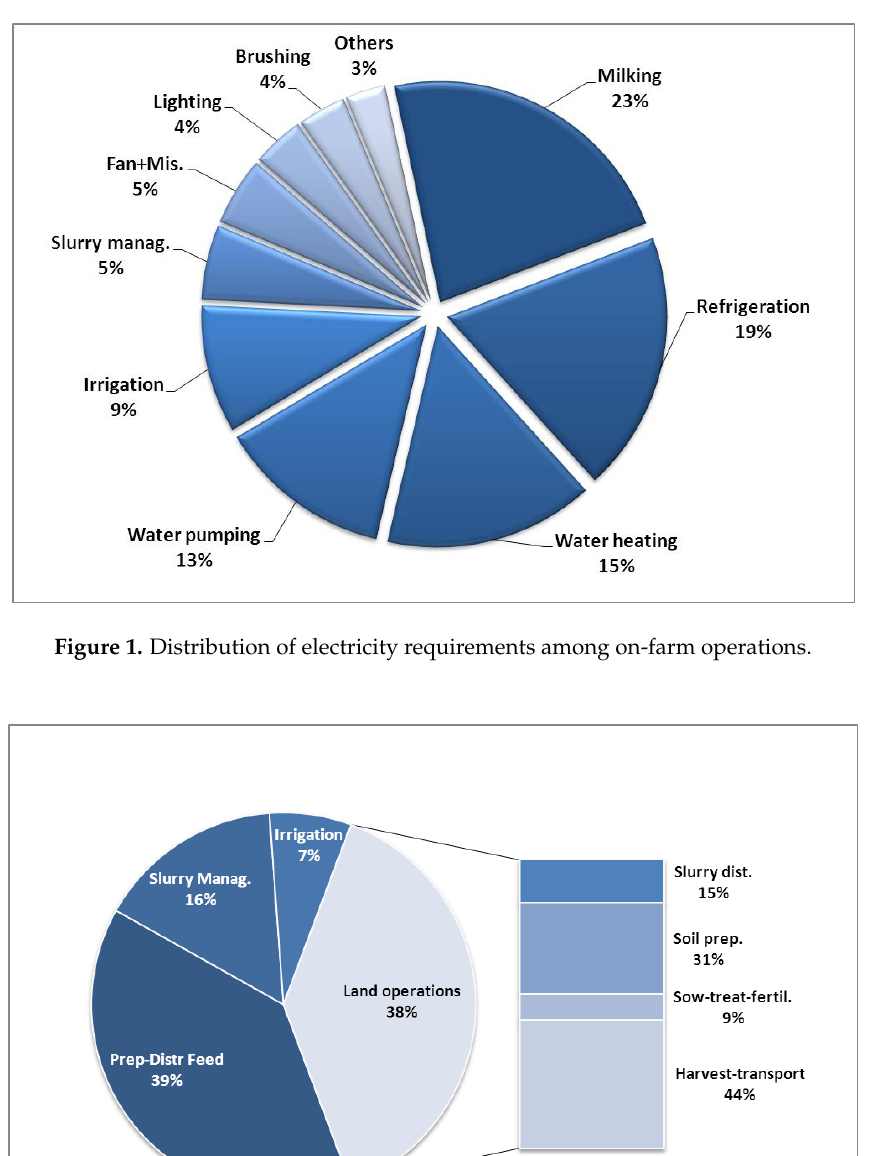
Figure 2. Distribution of diesel fuel utilization among on-farm activities.